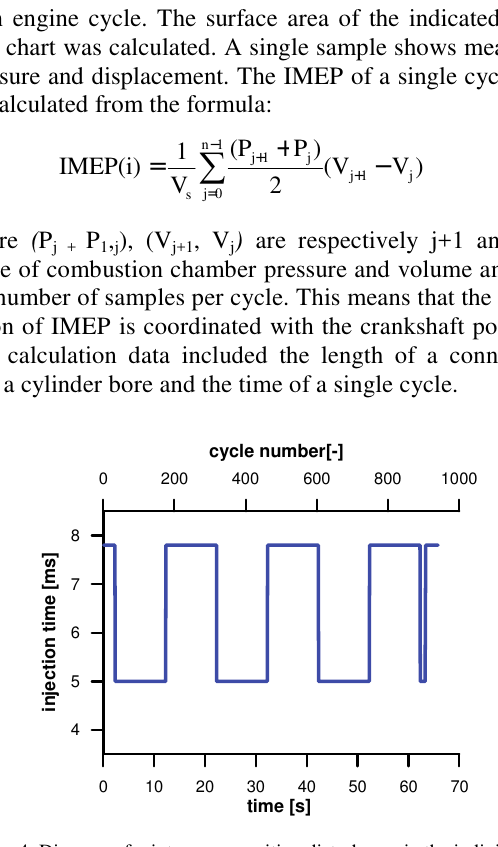
Fig. 4. Diagram of mixture composition disturbance in the individual cylinder [6]